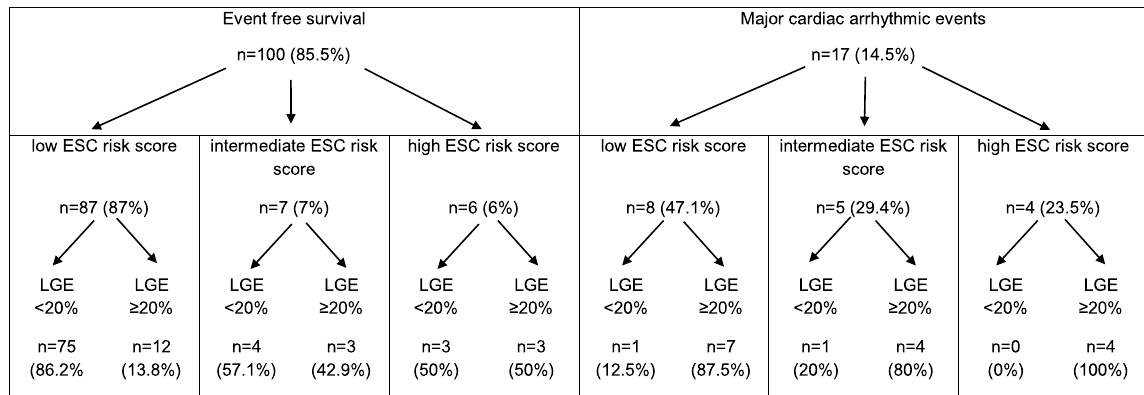
Table 3. Distribution of patients according to ESC risk score and late gadolinium enhancement in CMR. Abbreviations: ESC = European Society of Cardiology, LGE = late gadolinium enhancement, n = number